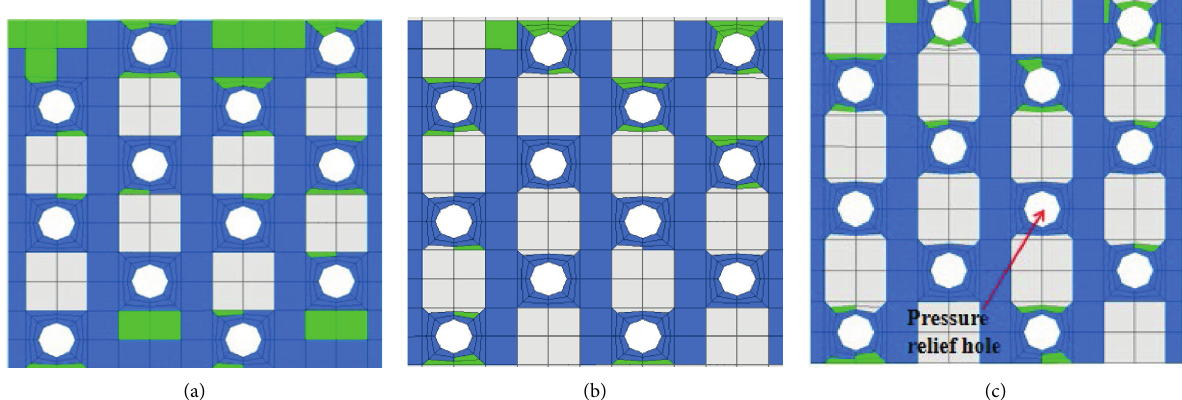
Figure 11: Distribution law of plastic zone of 300mm pressure relief hole. (a) 4m from the coal rib. (b) 6m from the coal rib. (c) 8m from the coal rib.